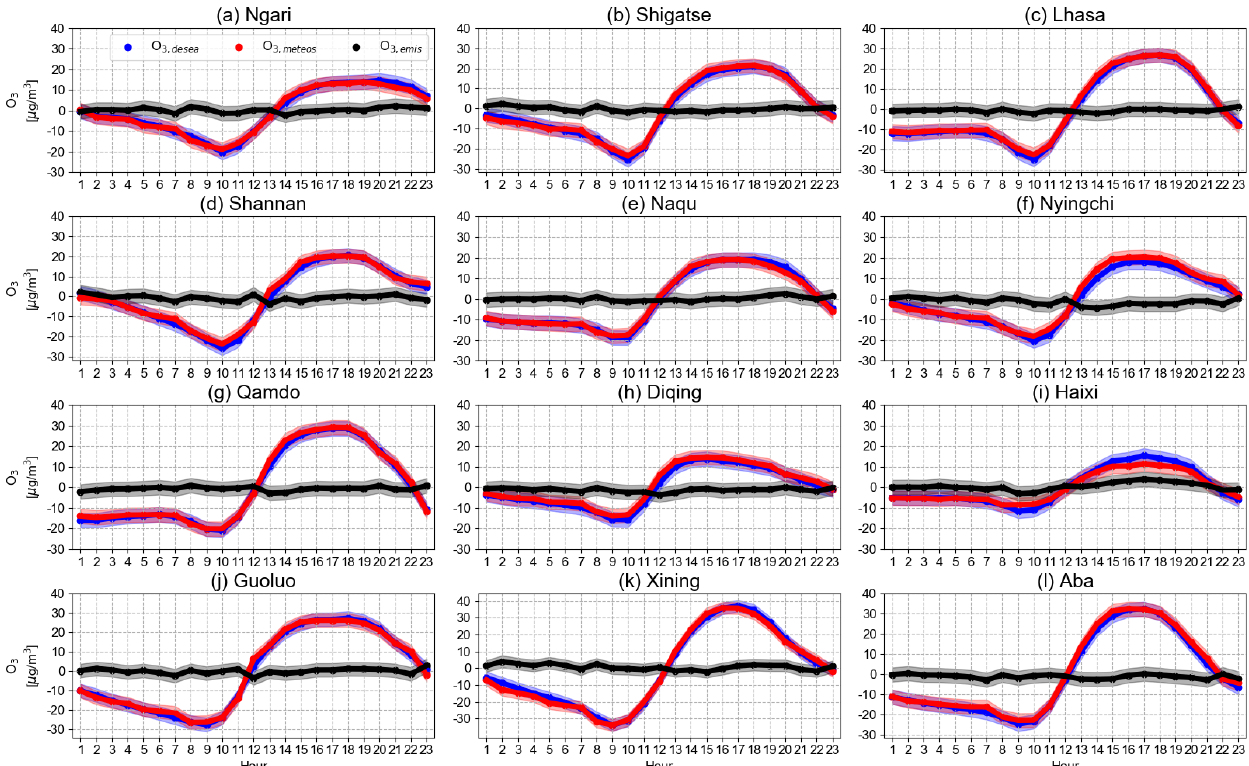
Figure 6. Diurnal cycles of surface ozone anomalies (O 3 , anomalies , blue dots and lines) along with the meteorology-driven portions (O 3 , meteo , red dots and lines) and the anthropogenic-driven portions (O 3 , emis , black dots and lines) in each city over the QTP. Bold curves and the shadows are diurnal cycles and the 1 σ standard variations